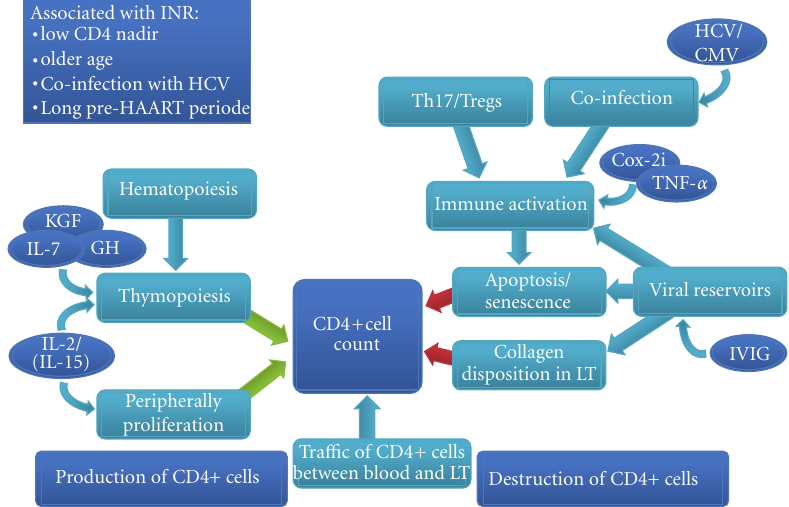
Figure 1: Factors influencing CD4+ cell count (LT: lymphatic